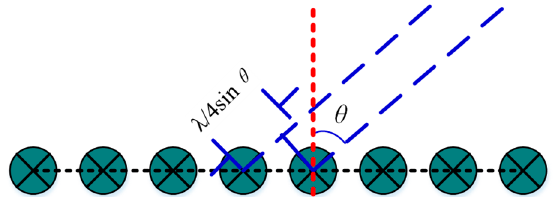
Figure 3. Direction of arrival estimation with an array. At the discrete time tick